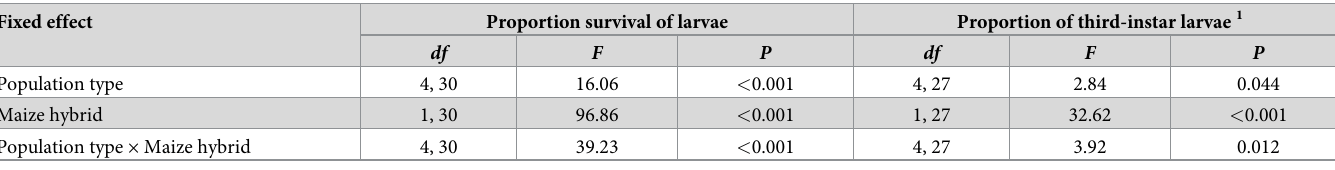
Table 1. Analysis of variance for data from plant-based